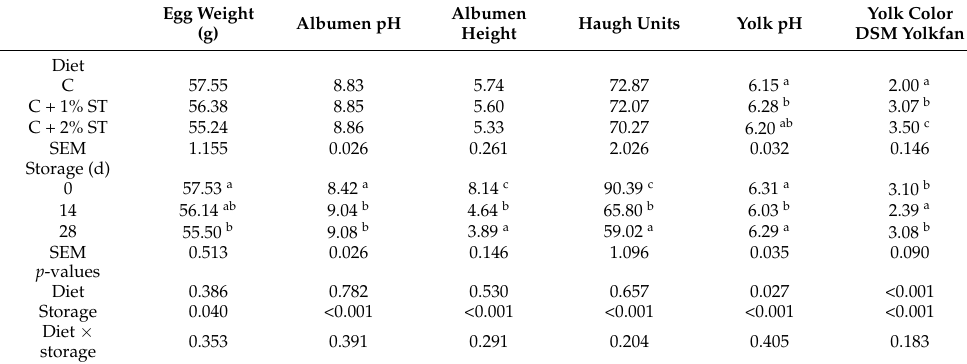
Diet <0.001 <0.001 <0.001 0.539 Time <0.001 <0.001 <0.001 <0.001 Diet × time <0.001 0.040 <0.001 0.432 * Analyses were performed on the mixed yolk and albumen. Values in a column with different letters differ significantly. C = control diet; SEM = pooled standard error of means; p = Fisher’s probability; values in a row with different letters differ significantly. Table 6. The effect of dietary stevia and length of storage on egg quality variables. Egg Weight (g) Albumen